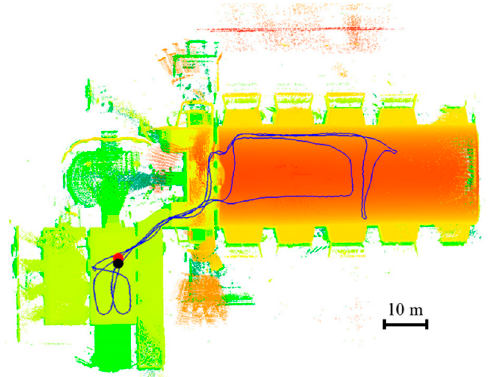
Figure 19. The data acquisition trajectory. The blue line is the trajectory. The red dot and black dot in the figure represent the start and end of trajectory respectively.